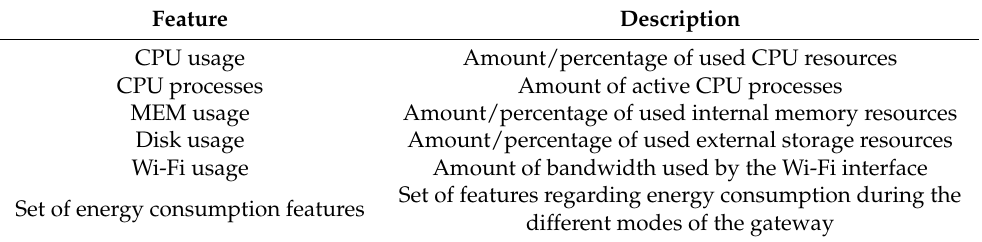
Table 6. Summary of features collected by the gateway data collection module of the CD component and their